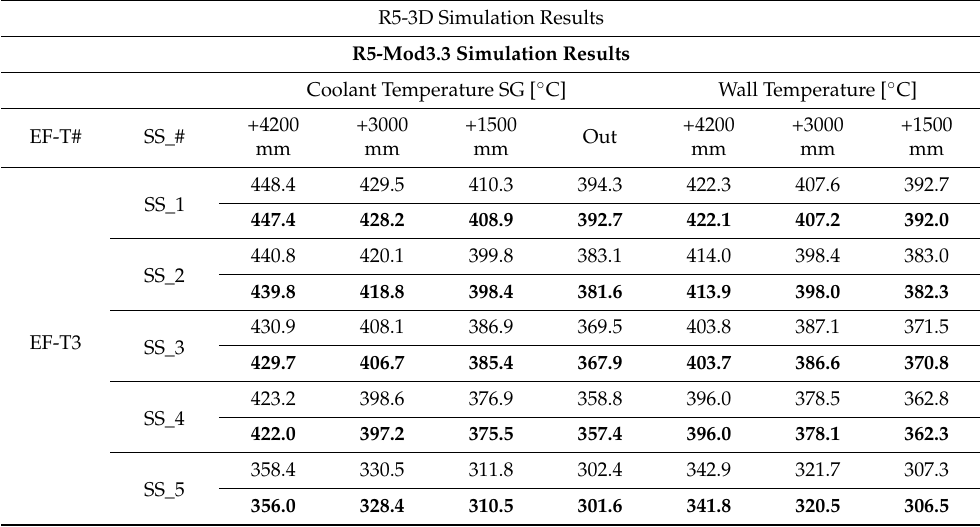
Table 3. EF-T3: RELAP5-3D/RELAP5/Mod3.3 (in bold) simulation results